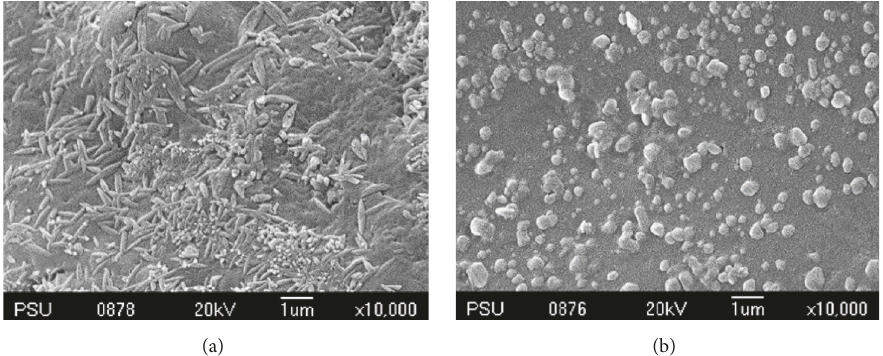
Figure 2: SEM micrographs of (a) NaCMC and (b) NaCMC-g-PAA superabsorbent polymer.